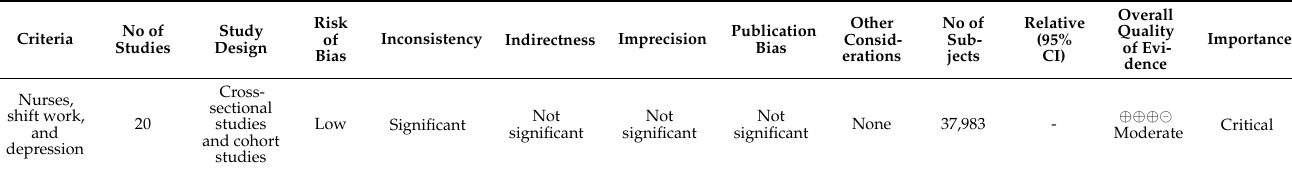
Table 3. GRADE assessment of evidence